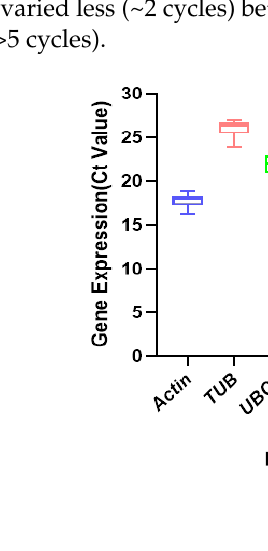
Figure 2. Expression profiles of the eight candidate reference genes in different experimental conditions. ( a ) Different temperature treatment; ( b ) Different developmental stages. The expression levels of the candidate reference genes are shown as Ct values. The box represents the 75th to 25th percentiles and the line in the box represents the median. The whiskers on each box represent the minimum and maximum Ct values.